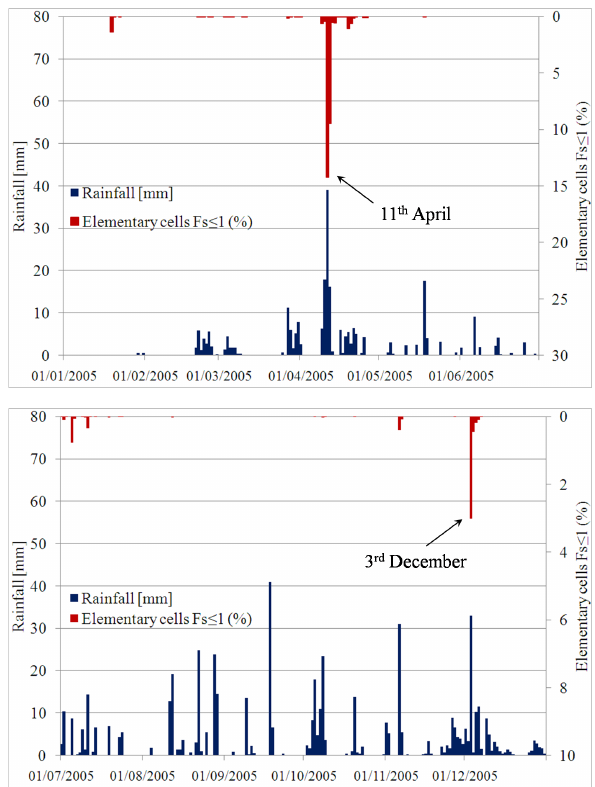
Figure 15 Fig. 15. SLIP analysis on the study area: daily percentage of cells characterised by F s ≤ 1 (unstable condition) with respect to the daily mean rainfall depth. (a) calibration period, from the 1 Jan- uary to the 30 June 2005; (b) prediction period, from the 1 July to the 31 December